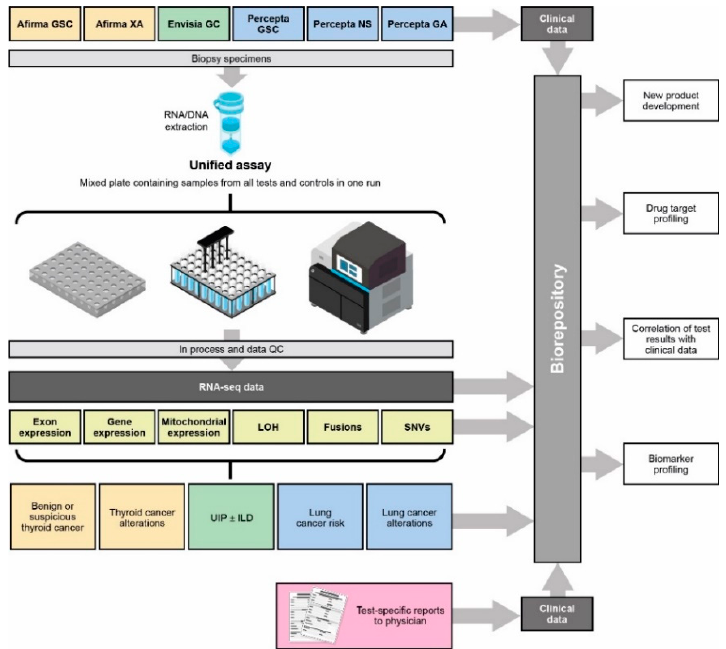
Figure 1. Unified Assay workflow. GA, genomic Atlas; GC, genomic classifier; GSC, Genomic Sequencing Classifier; ILD, interstitial lung disease; LOH, loss of heterozygosity; NS, nasal swab; SNV, single-nucleotide variant; UIP, usual interstitial pneumonia; XA, Expression Atlas.